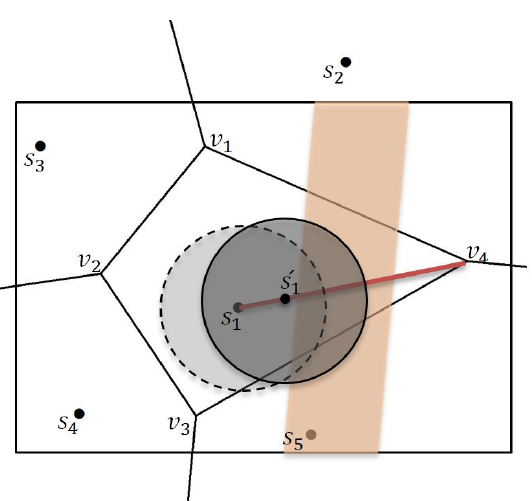
Figure 20. Sensor’s move representation in case of considering circular coverage and desirability coverage at the pink area (street), s 1 represents the initial sensor position, represents the position with highest weight score on the line s 1 v 4